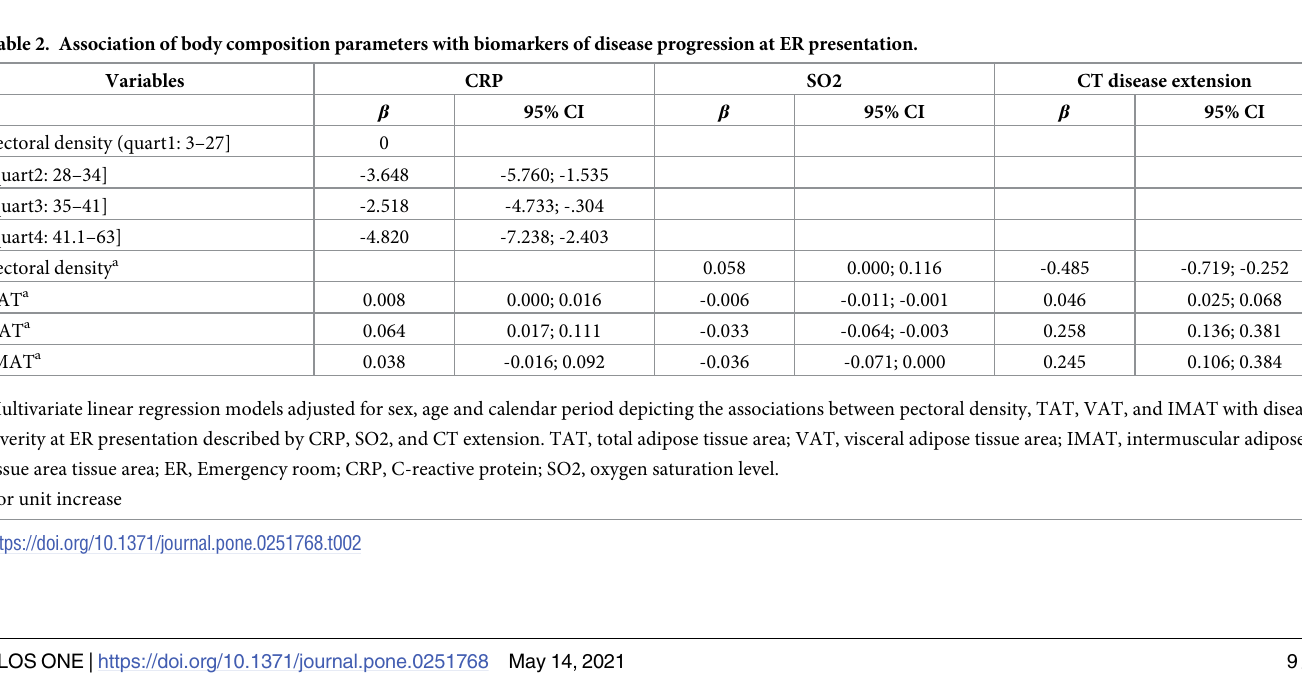
Table 2. Association of body composition parameters with biomarkers of disease progression at ER presentation. Variables